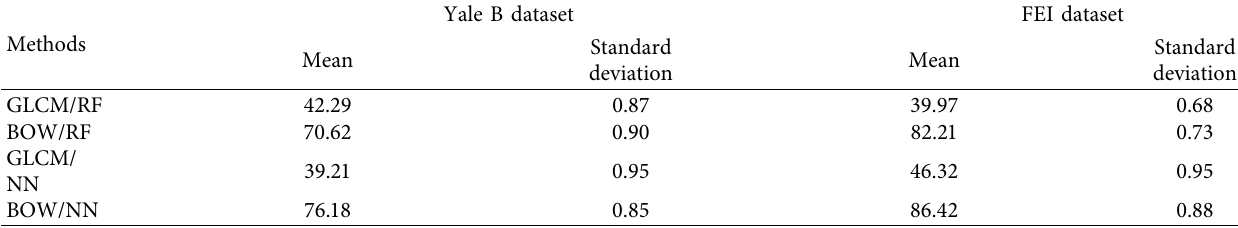
Table 5: The mean and standard deviation results for the GLCM and BOW methods using the random forest and the neural network (NN) classifier with the FEI dataset.